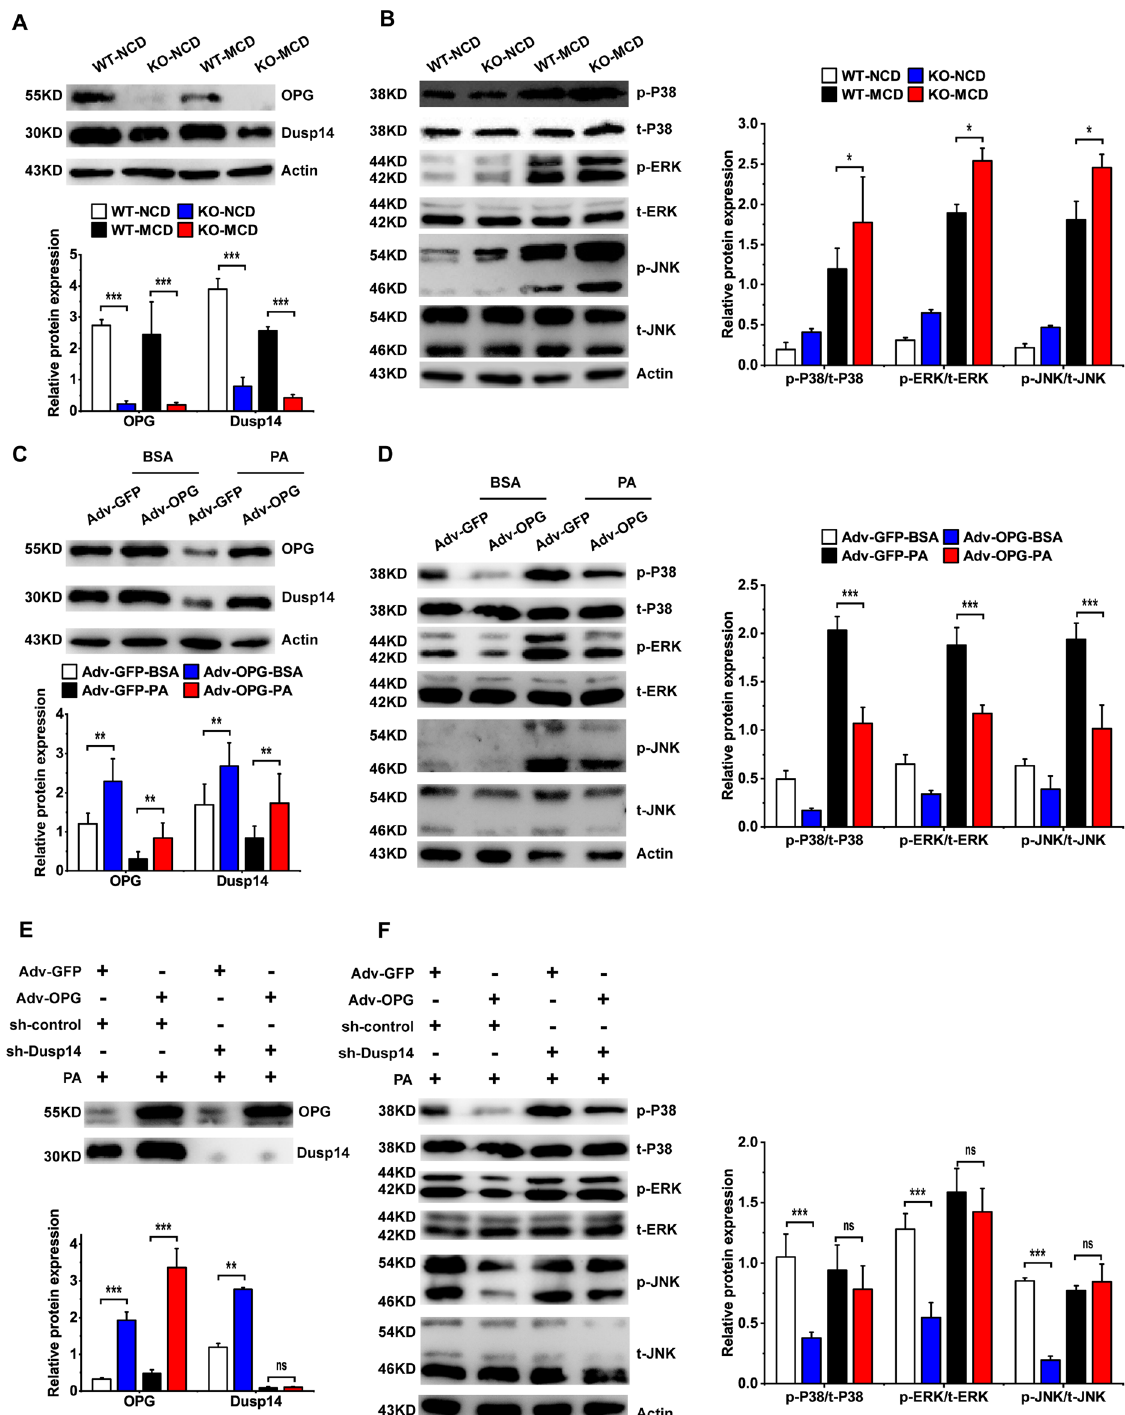
Figure 6. Osteoprotegerin (OPG) regulates MAPK signaling pathway activity via DUSP14. ( A ) OPG and dual specificity phosphatase 14 (DUSP14) protein levels in the mice. ( B ) Phosphorylation levels of extracellular signal-regulated kinases (ERK), c-Jun N-terminal kinase 1 (JNK), and P38 in mouse liver. ( C ) OPG and DUSP14 proteins in OPG-overexpressing hepatocytes. ( D ) Phosphorylation levels of ERK, JNK, and P38 in OPG-overexpressing hepatocytes. ( E ) OPG and DUSP14 proteins in DUSP14 knockout hepatocytes. ( F ) Phosphorylation levels of ERK, JNK, and P38 in DUSP14 knockout hepatocytes. Each group at least has 3 samples. The data in ( A – F ) are presented as the mean ± SD; ns no significant difference, *p < 0.0, **p < 0.01, and ***p <